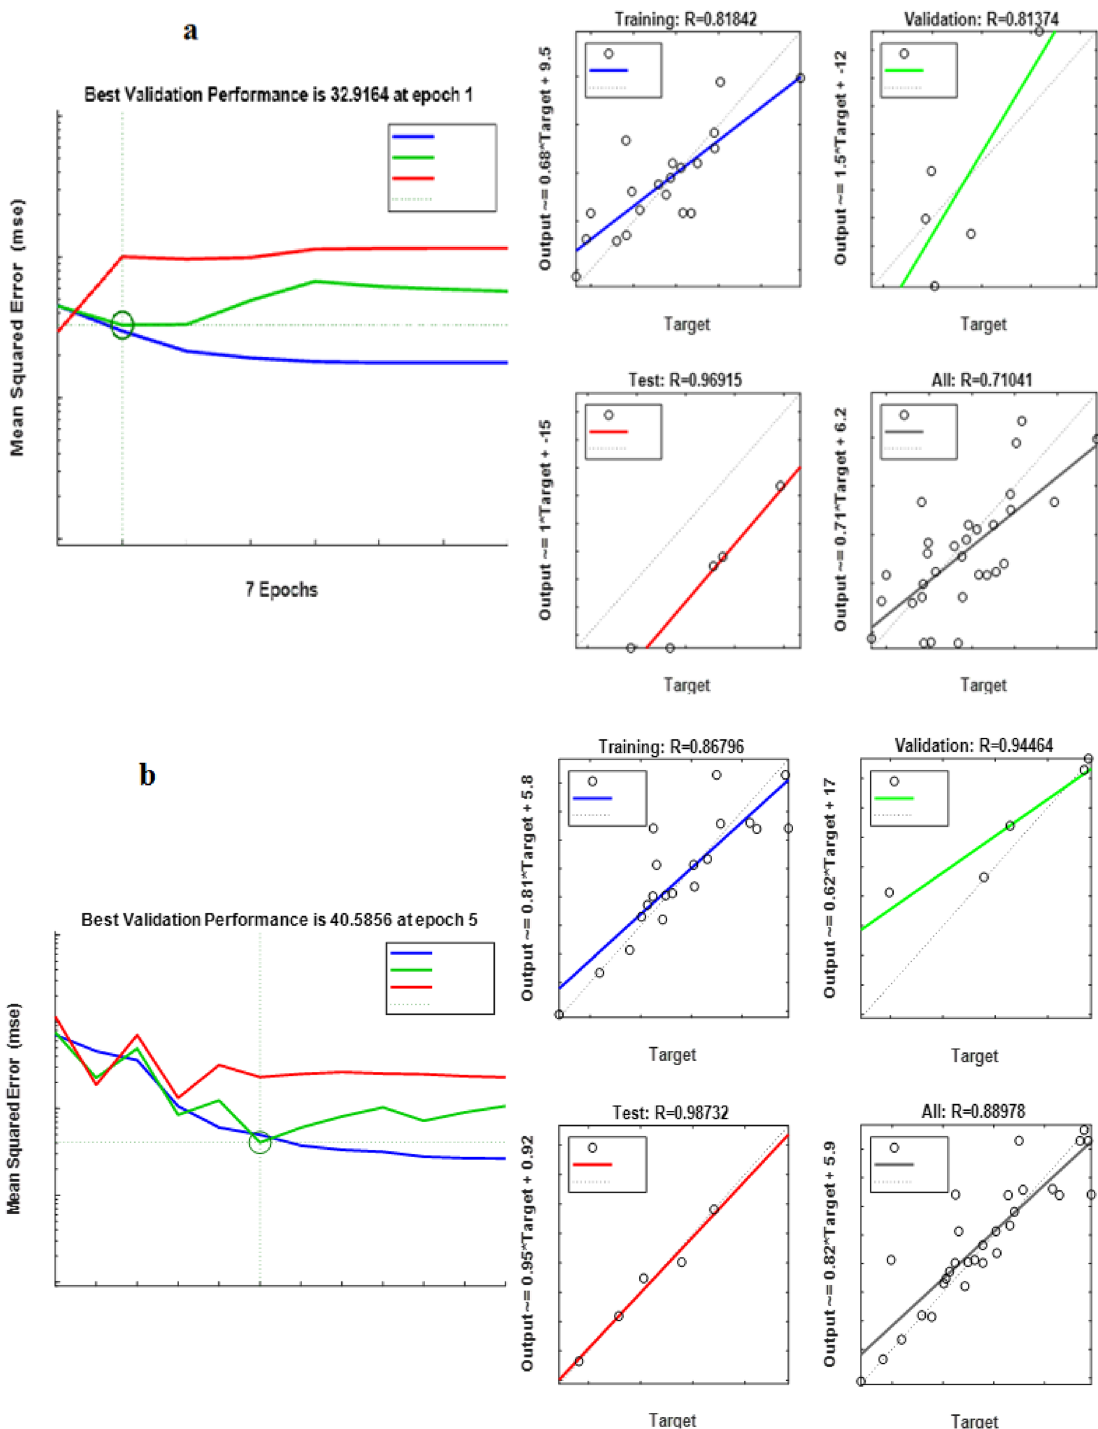
Figure 3. The performance of ANN. ( a ) Acintobacter , ( b ) Acromobacter and ( c ) consortium of Acintobacter and Acromobacter